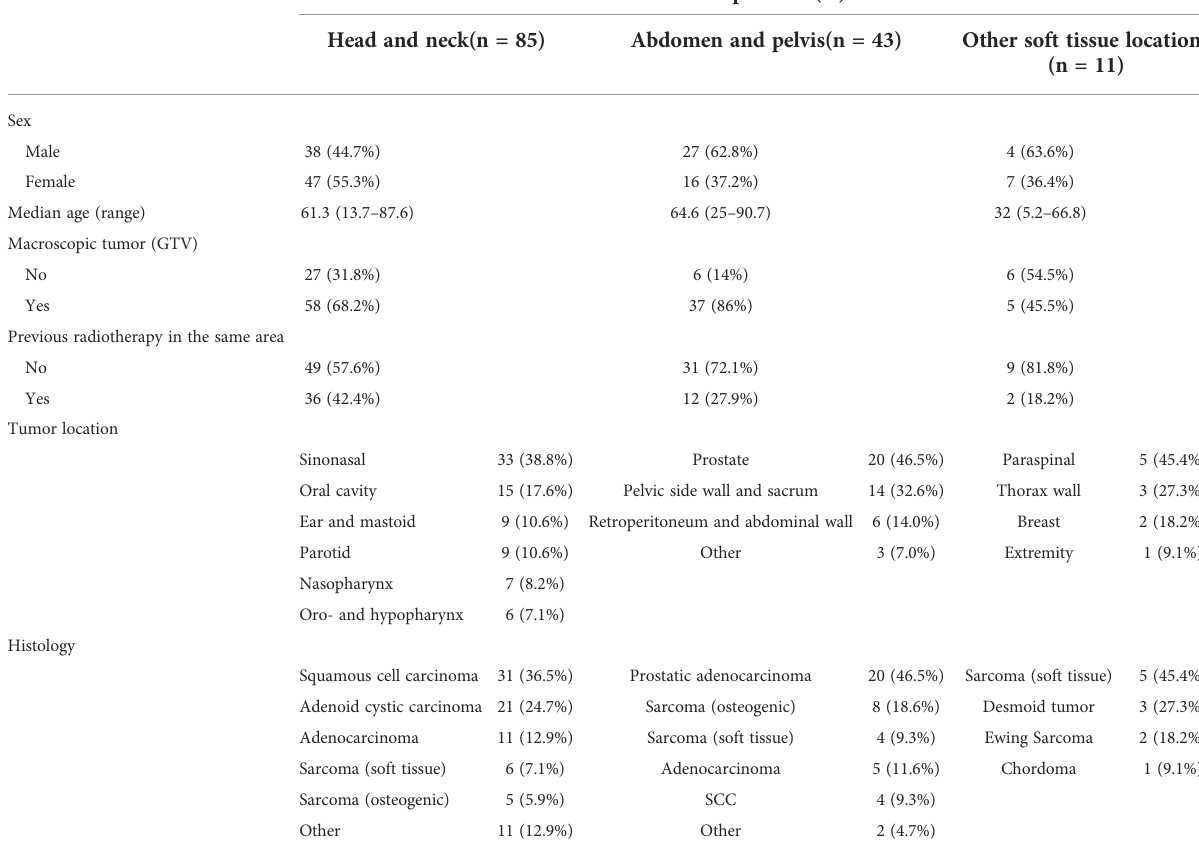
TABLE 1 Patient and tumor